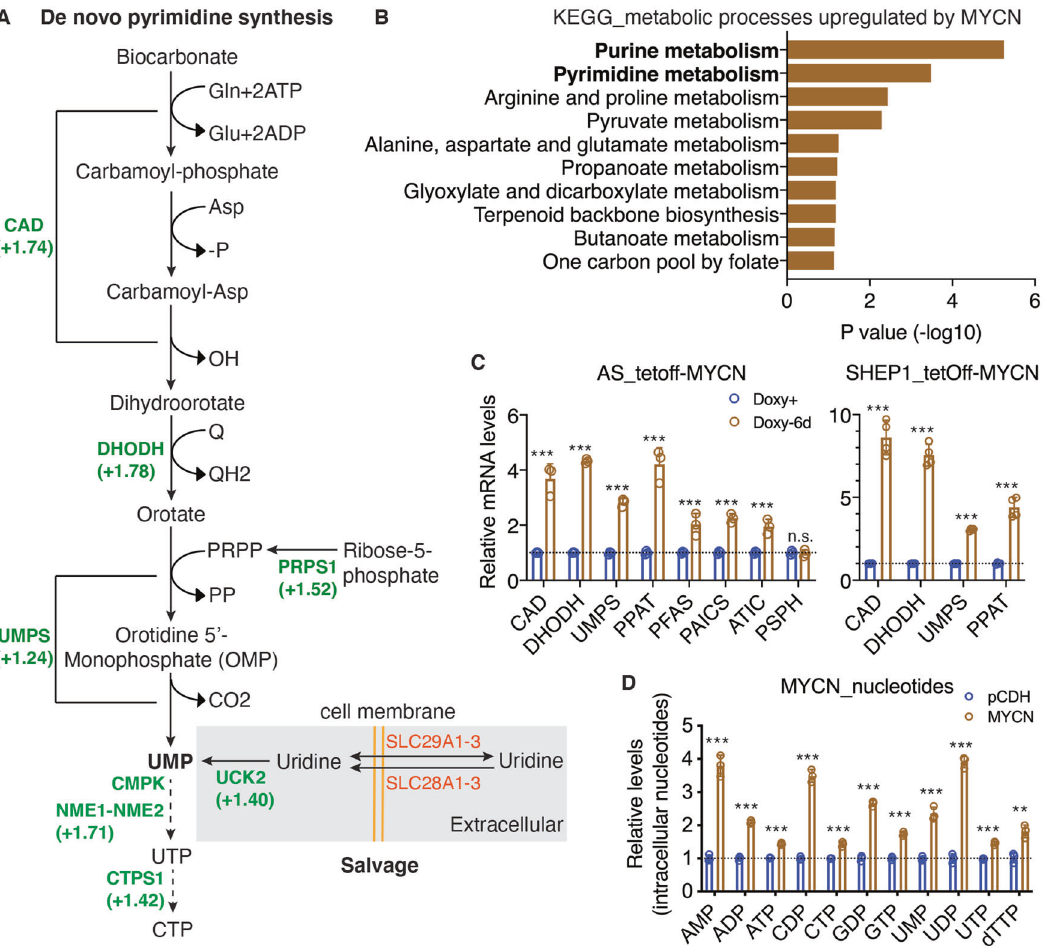
Fig. 1 MYCN promotes nucleotide synthesis. A Schematic of pyrimidine biosynthesis via de novo and salvage pathways with indicated fold changes in mRNA expression of the pathway enzymes determined by microarray. B Bar plot of KEGG metabolic processes upregulated by MYCN via transcriptional activation. C qRT-PCR analysis of mRNA expression for enzymes involved in de novo nucleotide synthesis in non- MYCN -ampli fi ed cell lines with inducible MYCN expression in the absence of doxycycline (Doxy) for six days. Data are mean ± SD ( n = 4). P values were determined by two-tailed Student ’ s t -test. *** P < 0.001, n.s., not signi fi cant. D Relative levels of intracellular nucleotides in non- MYCN -ampli fi ed SHEP1 cells with constitutive MYCN expression (MYCN) in comparison with vector-control cells (pCDH). Data are mean ± SD ( n = 3). P values were determined by Welch ’ s t -test. ** P < 0.01, *** P <